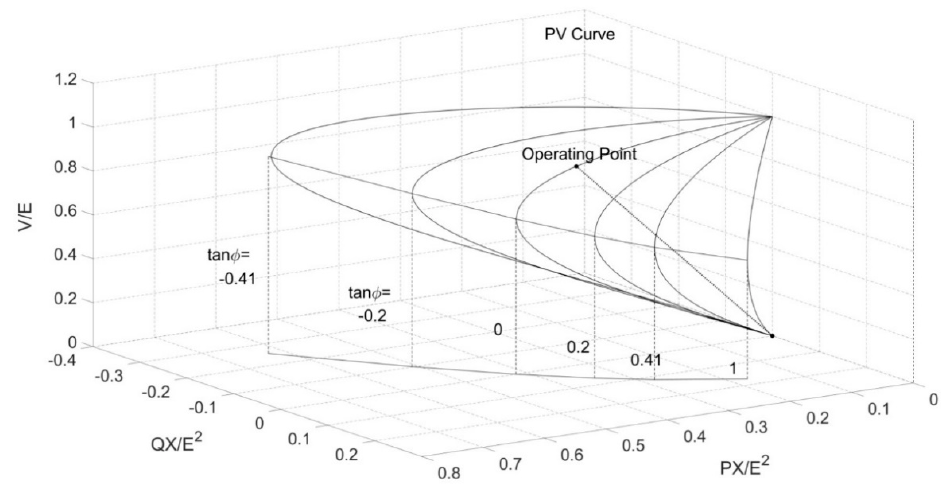
Figure 1. Photovoltaics (PV) curve.